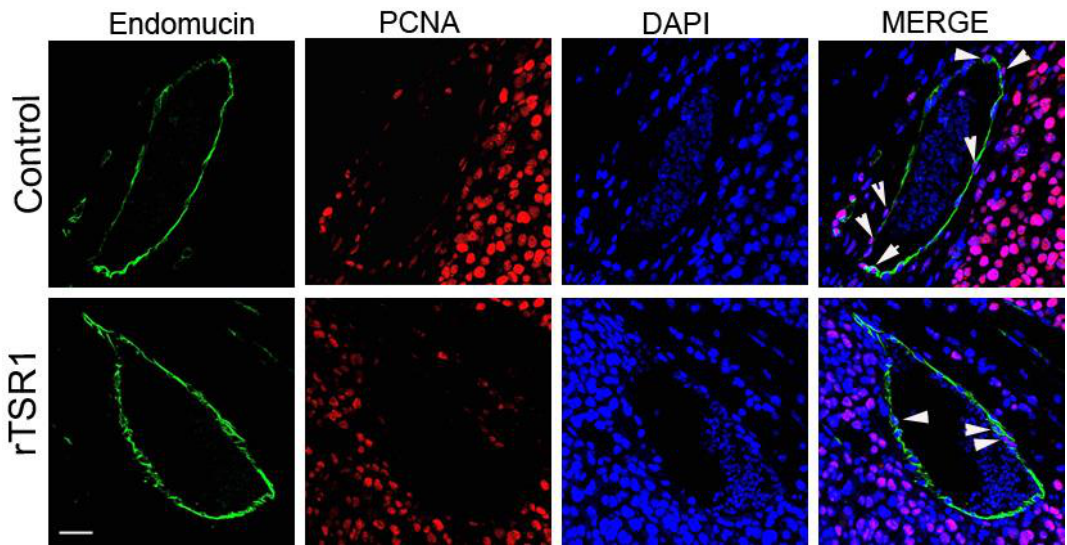
Figure 4. The rTSR1 suppressed tumor endothelial cell proliferation. Representative microscopic images show decreased proliferating endothelial cells in an rTSR1-treated tumor compared to the control. Green indicates the endothelial cells (endomucin-positive), and red indicates the nuclear PCNA-positive proliferating cells. DAPI (4′,6-diamidino-2-phenylindole) was used as the nuclear counter stain. The arrow heads indicate the nuclear PCNA-positive tumor endothelial cells. Scale bar: 30 μm.